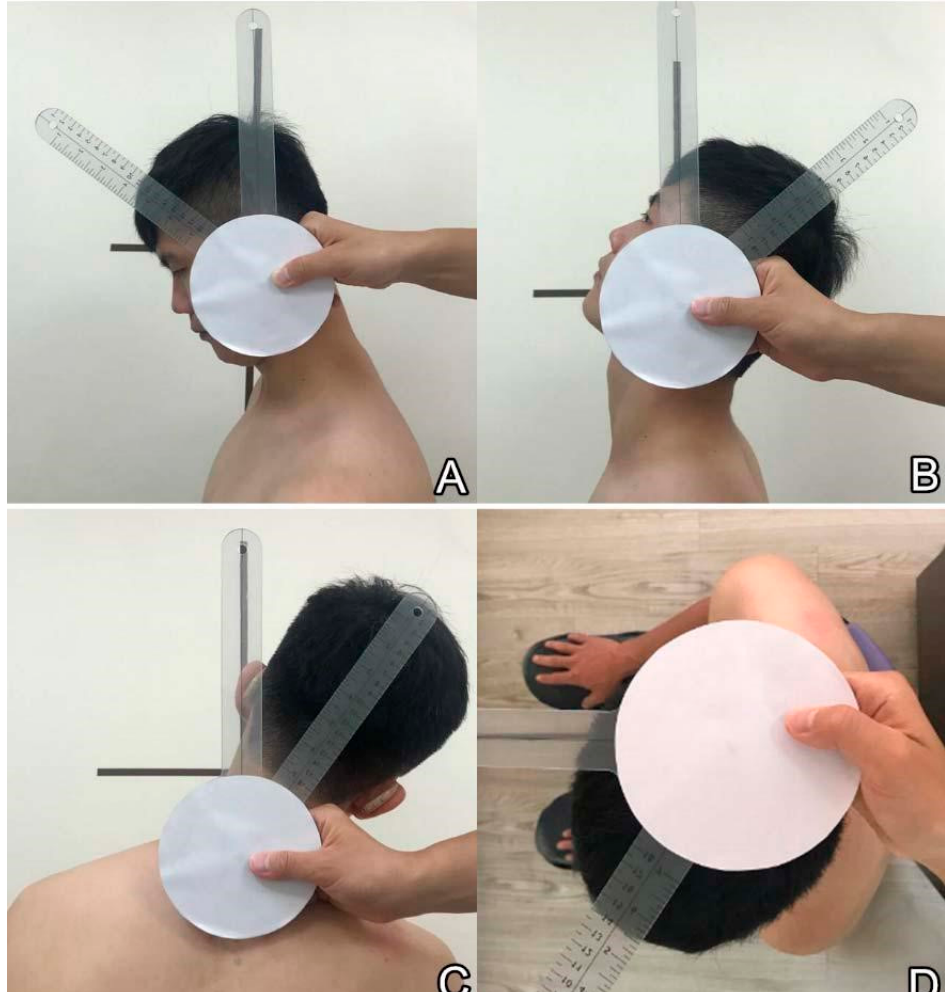
Figure 2. Use of the universal goniometer to measure craniocervical ranges in ( A ) flexion, ( B ) extension, ( C ) side-bending and ( D ) rotating. During the examination, some vertical and horizontal lines were marked on the wall and floor as references for cervical motions and goniometer placement. One side of the scale was covered by white paper. The investigators were not aware of the exact angles until the end of examination when the non-covered side is flipped toward them.